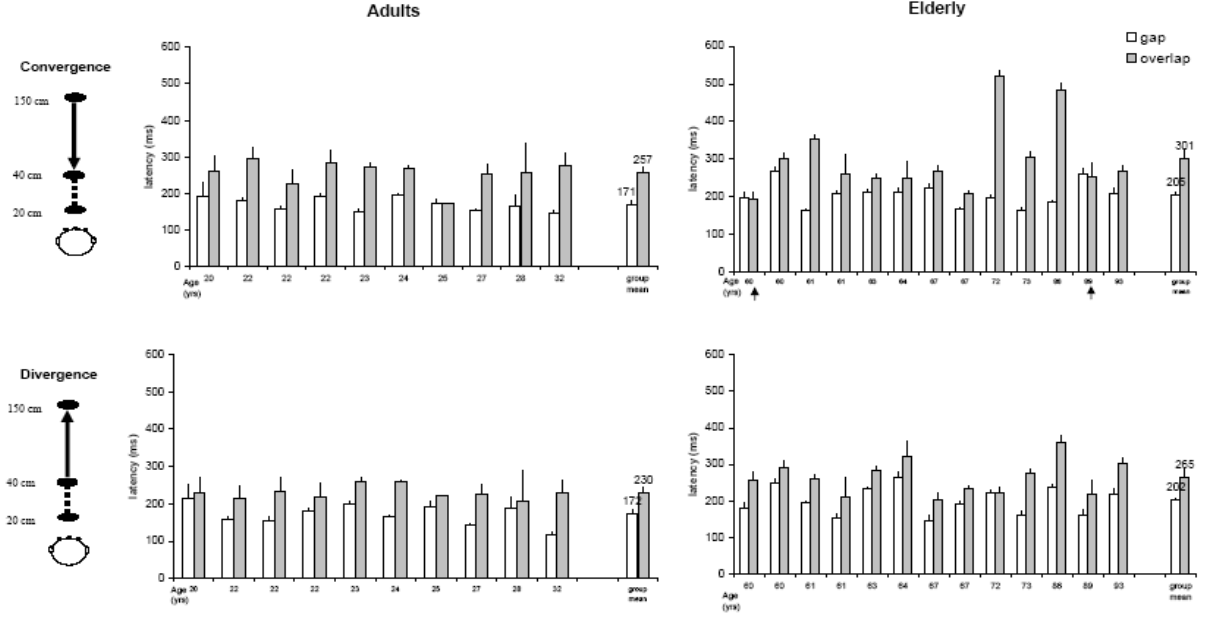
Figure 3. Individual and group mean latency with standard errors for convergence or divergence starting from far fixation point (two LEDs at 40 cm and 150 cm in front of subject, respectively) in the gap and the overlap conditions for both young and elderly sub-